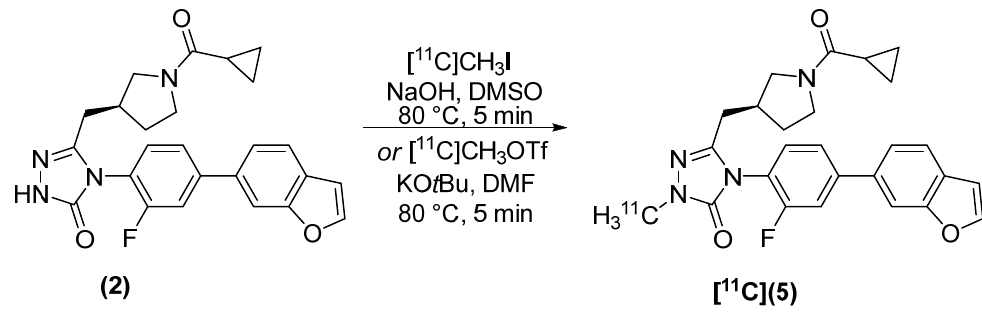
Figure 3. Radiosynthesis of [ 11 C]( 5 ).